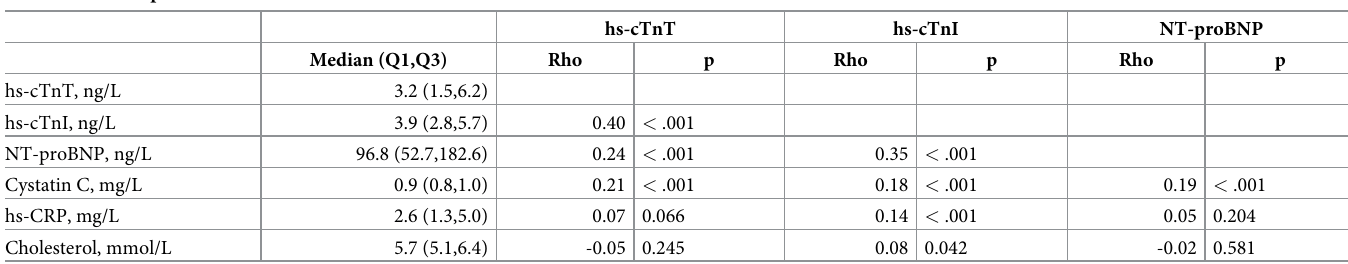
Table 2. Partial Spearman rank correlation coefficients.